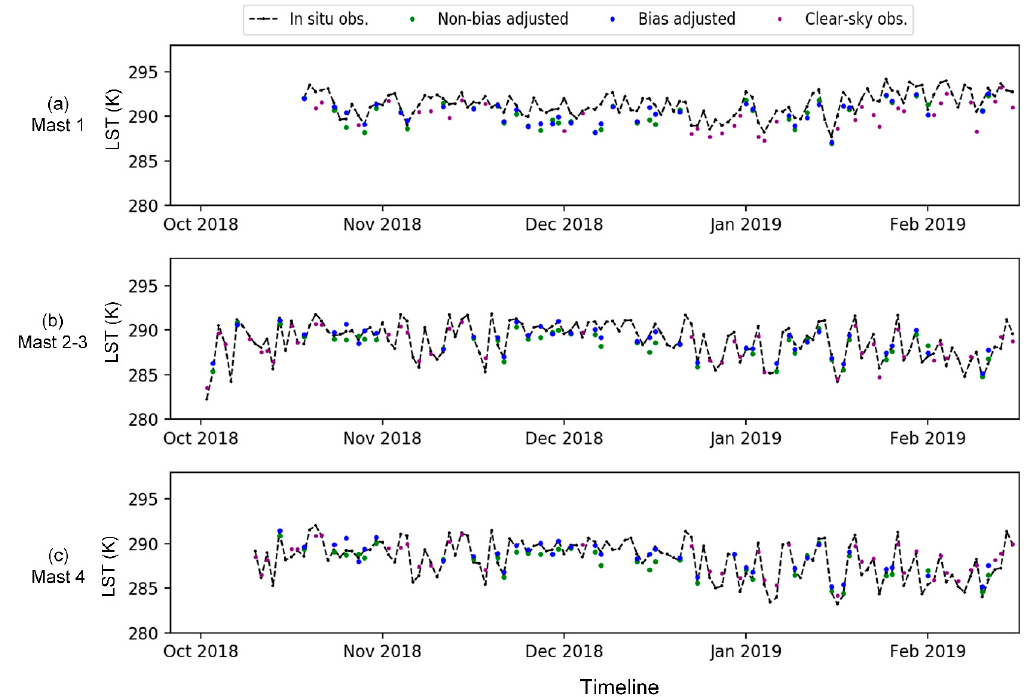
Figure 7. Time series of MODIS cloud gap filled night-time LSTs and corresponding in situ LSTs recorded at the locations of ( a ) Mast 1, ( b ) Masts 2 and 3 (averaged), and ( c ) Mast 4 of the ILRI Kapiti Research Station.